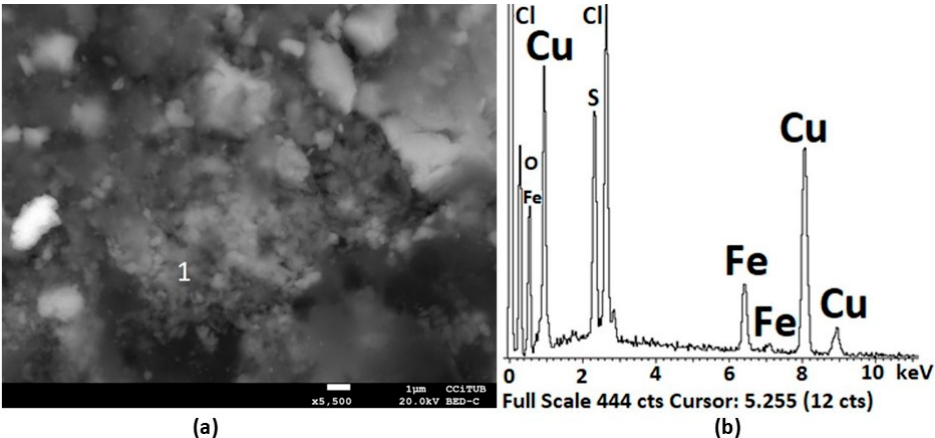
Figure 14. SEM image ( a ) and EDS analysis ( b ) of zone 1. The EDS confirms the formation of Cu 2 Cl(OH) (1) in the products of the pretreatment of chalcopyrite mineral with 15 kg/t of H 2 SO 4 , 25 kg/t NaCl, and 15 days of curing at room temperature. In ( a ) at a magnification of ×5.500.